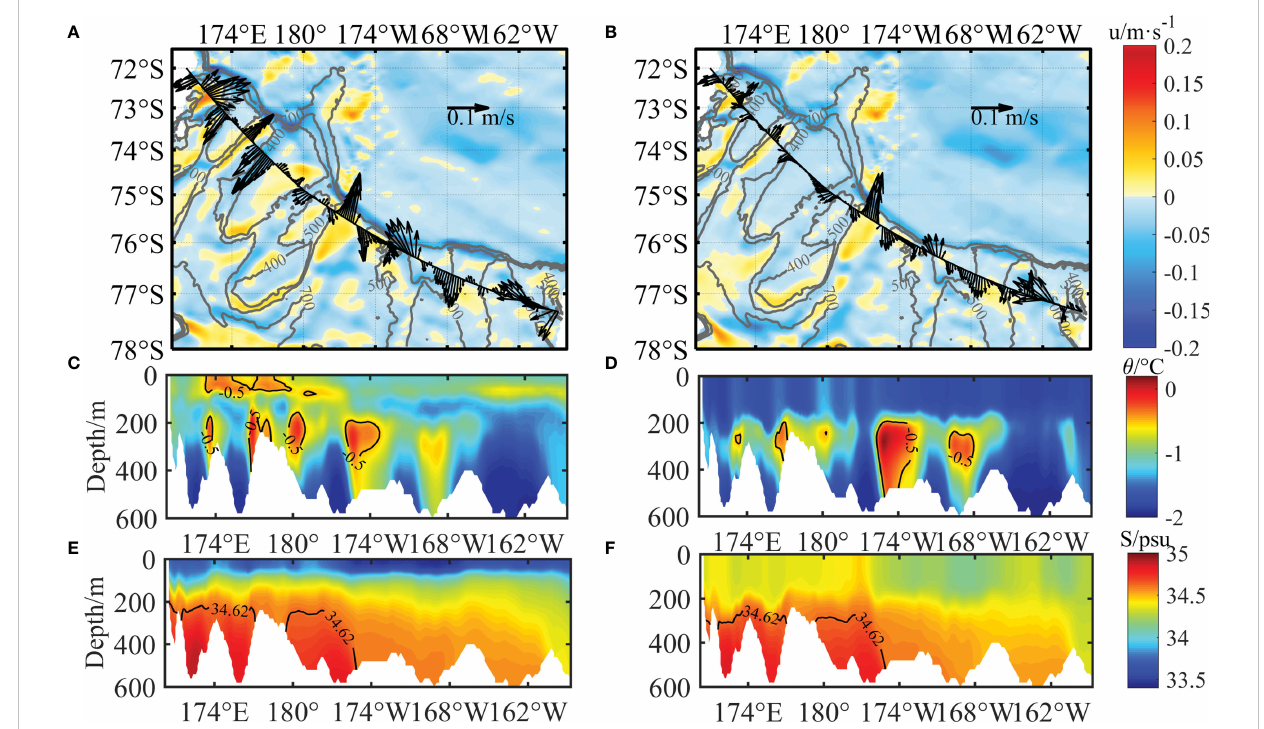
FIGURE 2 (A, B) Climatological depth-averaged currents (vectors) along Transect 1 and west – east components of velocities (blue, westward; red, eastward) in February and August, respectively, and isobaths (gray lines). (C, D) Climatological vertical sections of potential temperature (colors) along Transect 1 in February and August and − 0.5°C isotherms (black lines) marking the core of MCDW. (E, F) Climatological vertical sections of salinity (colors) along Transect 1 in February and August and 34.62 psu isohalines (black lines) marking the HSSW and LSSW. MCDW, Modi fi ed Circumpolar Deep Water;